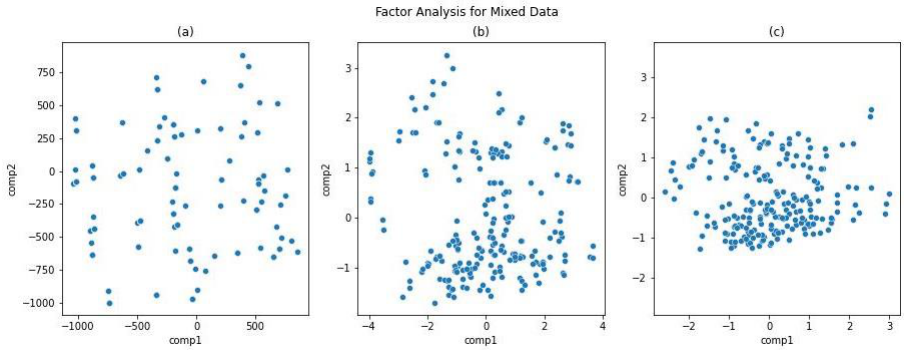
Figure 4. Two-dimensional representations of observations (houses) obtained with FAMD. ( a ) Based on qualitative variables. ( b ) Based on quantitative variables. ( c ) Based on both quantitative and qualitative variables